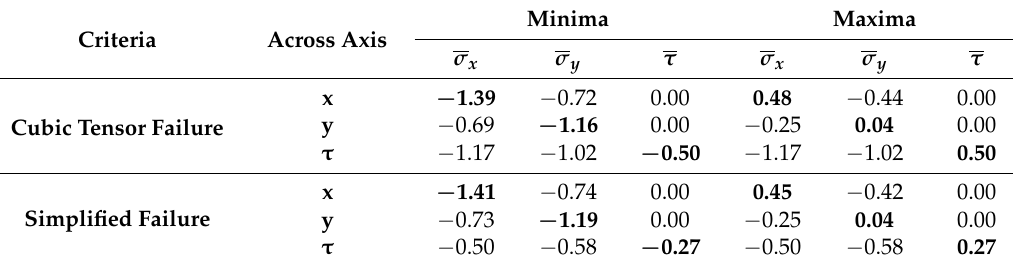
Criteria Across